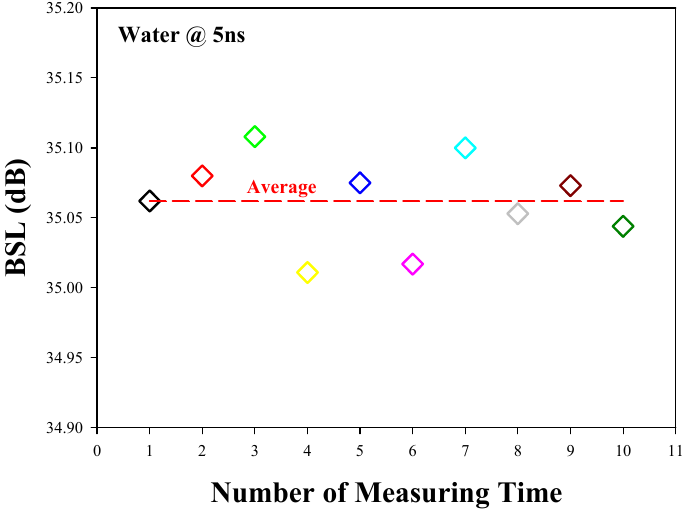
Figure 4. Output BLS levels from the OTDR traces at 1,100 m SMF long under 10 time measurements when the water is used for sensing and the 1,550 nm pulse laser is setup at 5 ns (red dashed line is the average value of measured